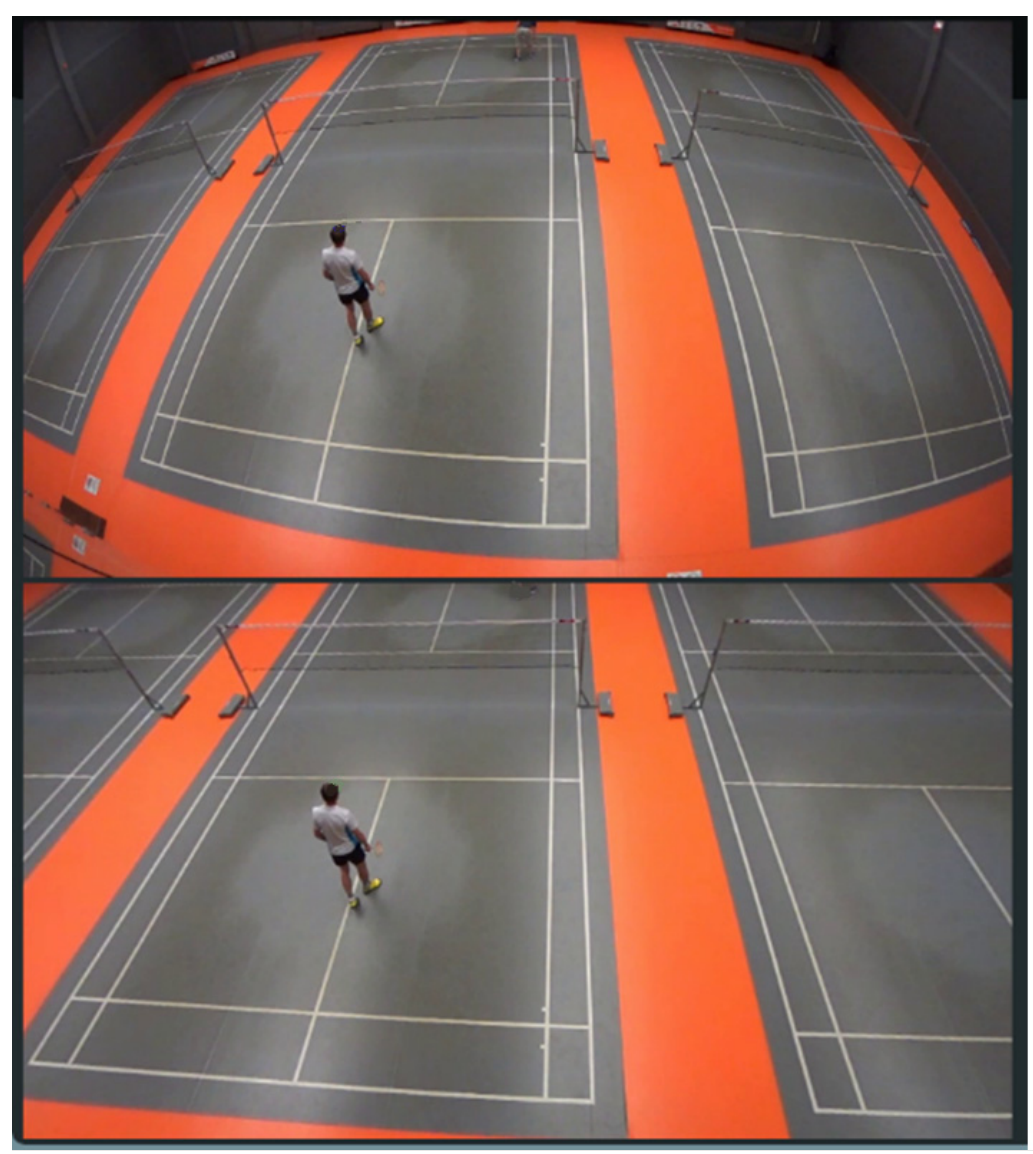
Figure 3. Original image ( upper ) and image after applying distortion coefficients calculated during the calibration process ( lower ).